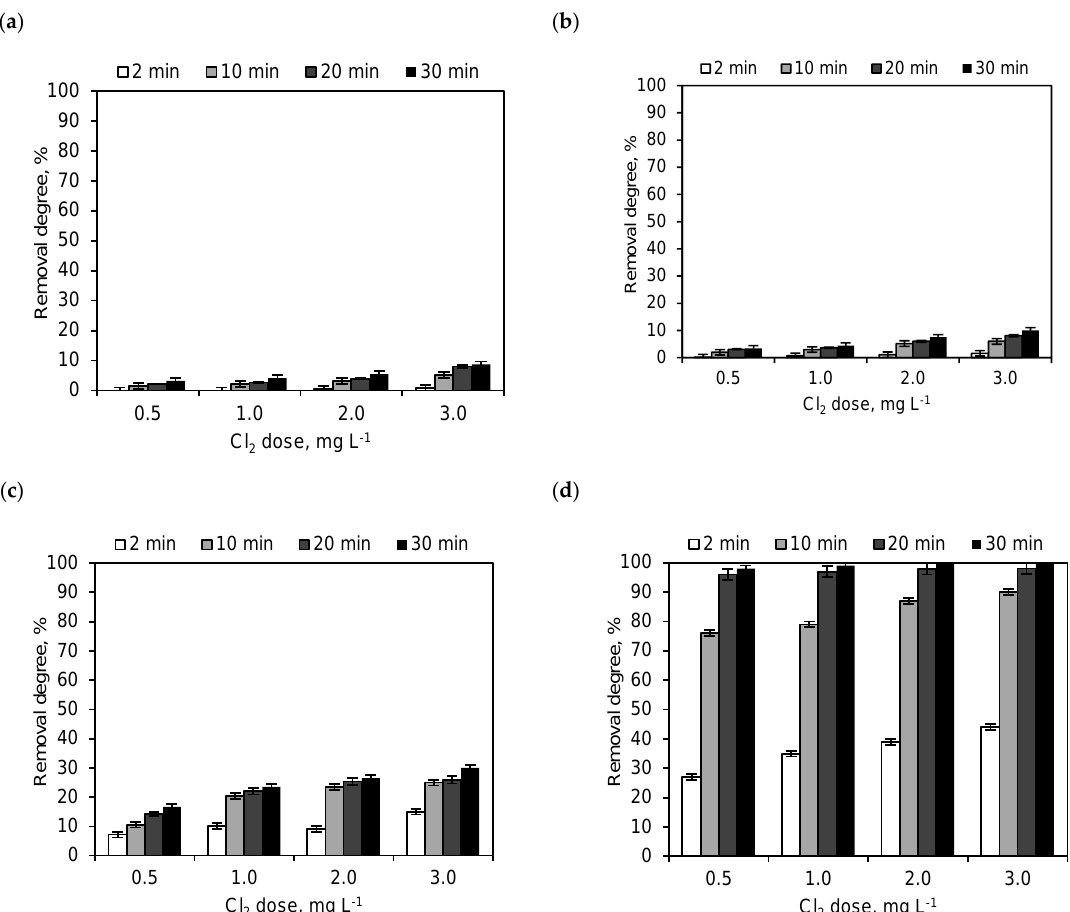
Figure 2. Change of ( a ) IBU, ( b ) BE, ( c ) ACR, and ( d ) E2 concentration during single chlorination of surface water solutions.